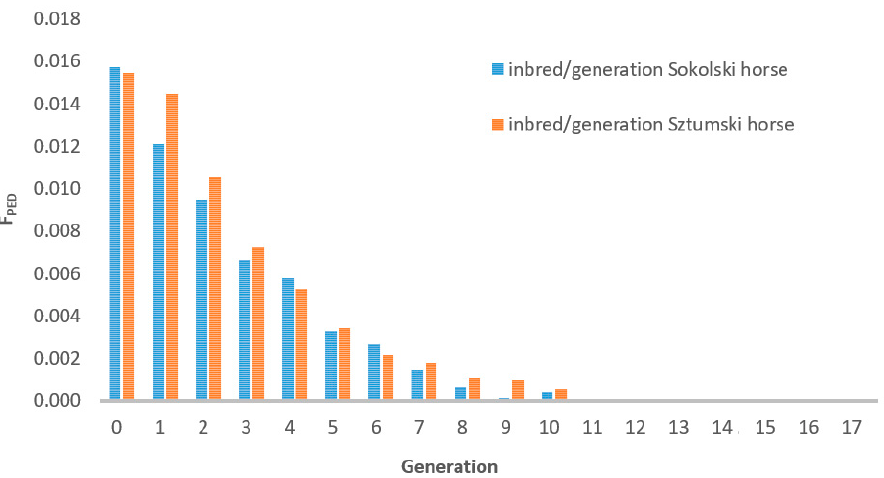
Figure 5. Increase of inbreeding in subsequent generations depending on the availability of pedigree information.